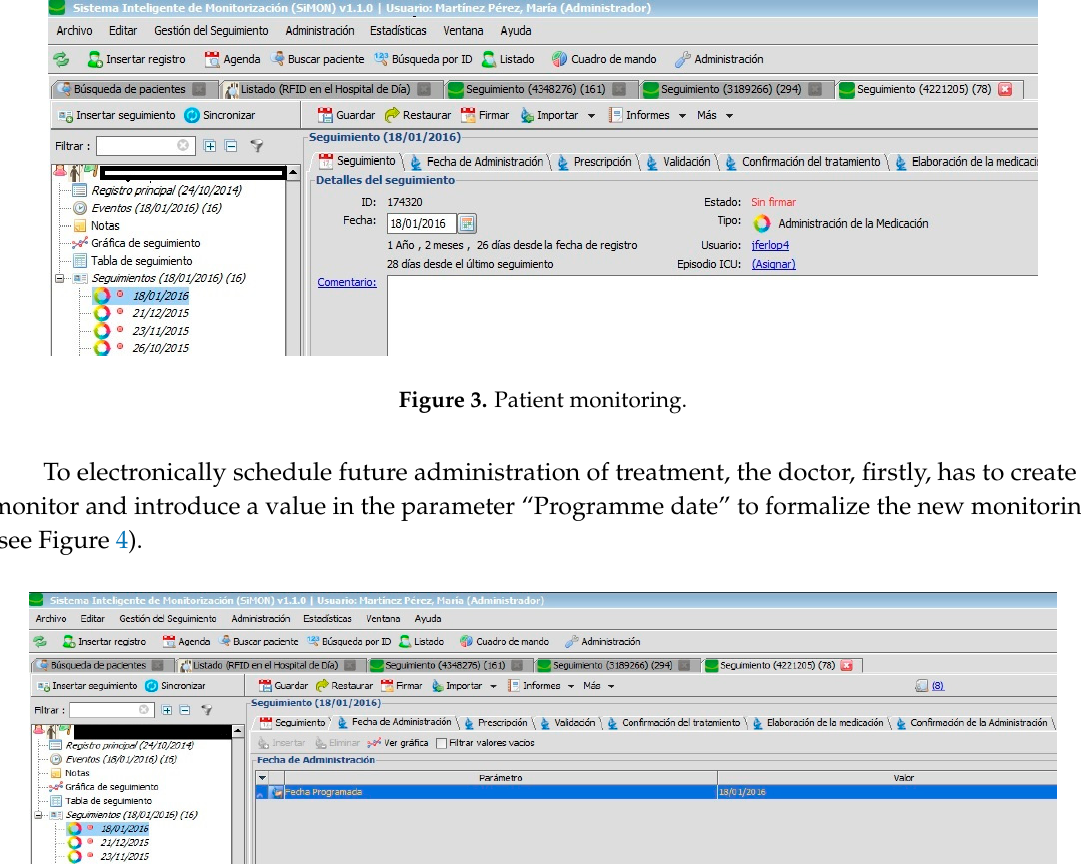
Figure 4. Date of administration programme.